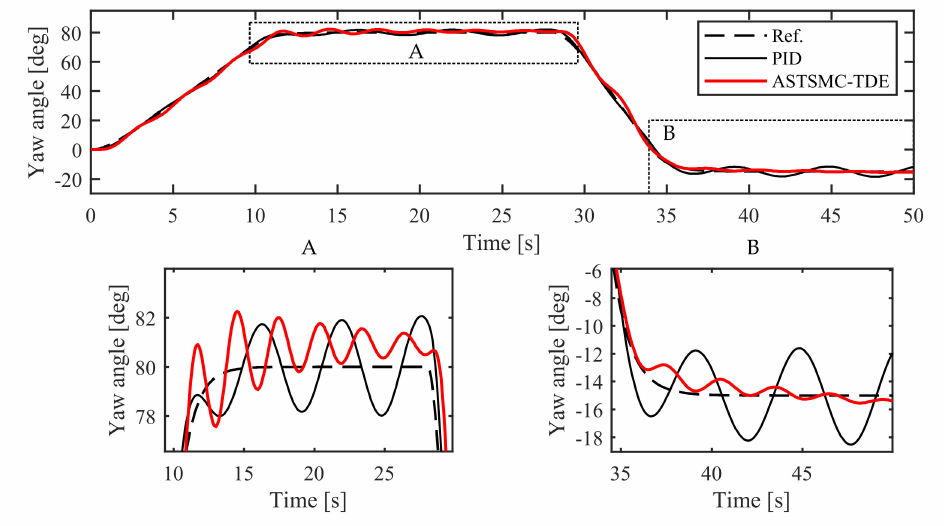
Figure 19. Experimental results of the yaw angle trajectory tracking in NM